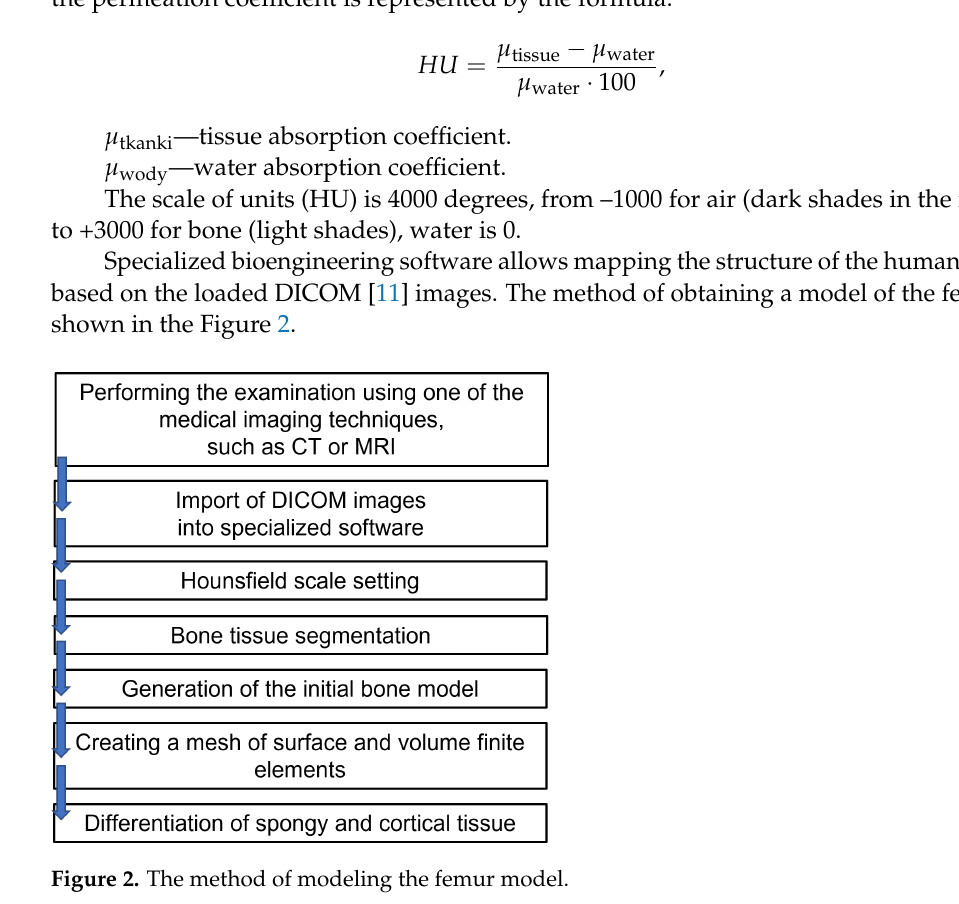
Figure 3. Models of the femur and